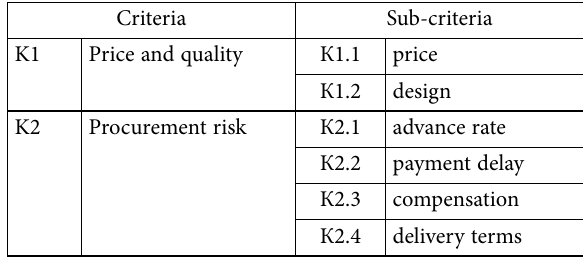
Table 5. Supplier selection main criteria and sub-criteria